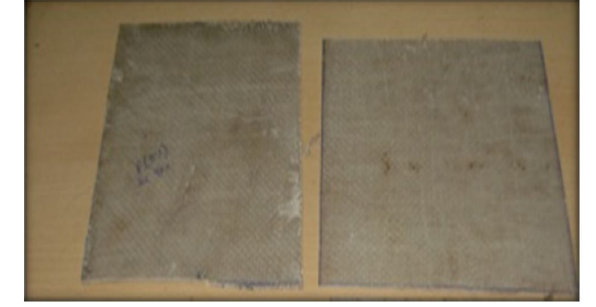
Fig. 2. Specimen for the drilling